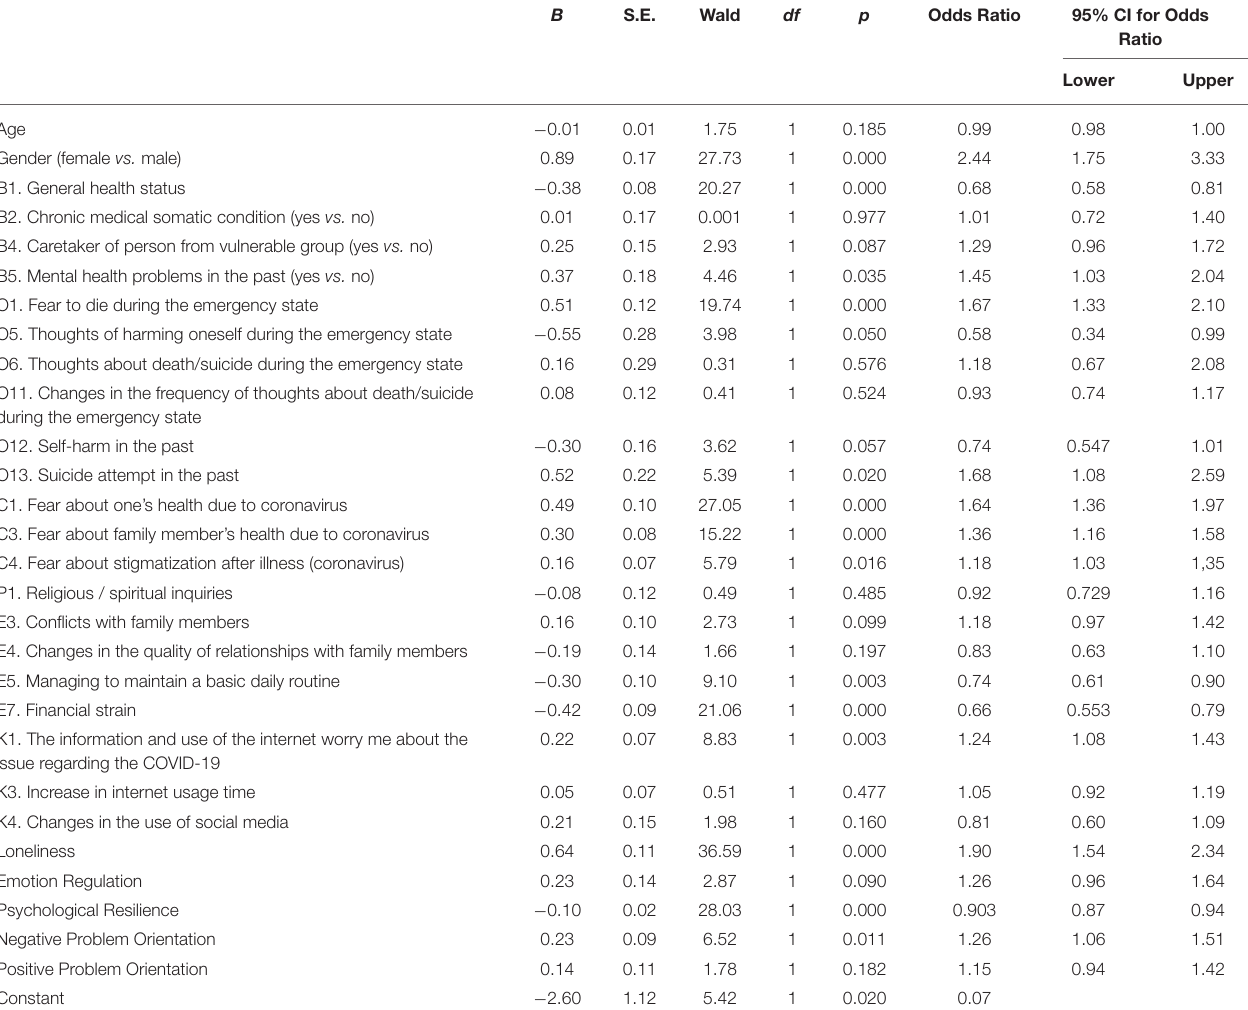
TABLE 8 | Logistic regression predicting likelihood of anxiety based on sociodemographic, health-related, relationship quality, daily routine, internet use and psychological characteristics in the general population of Latvia during the COVID-19 state of emergency. B S.E. Wald df p Odds Ratio 95% CI for Odds Ratio Lower